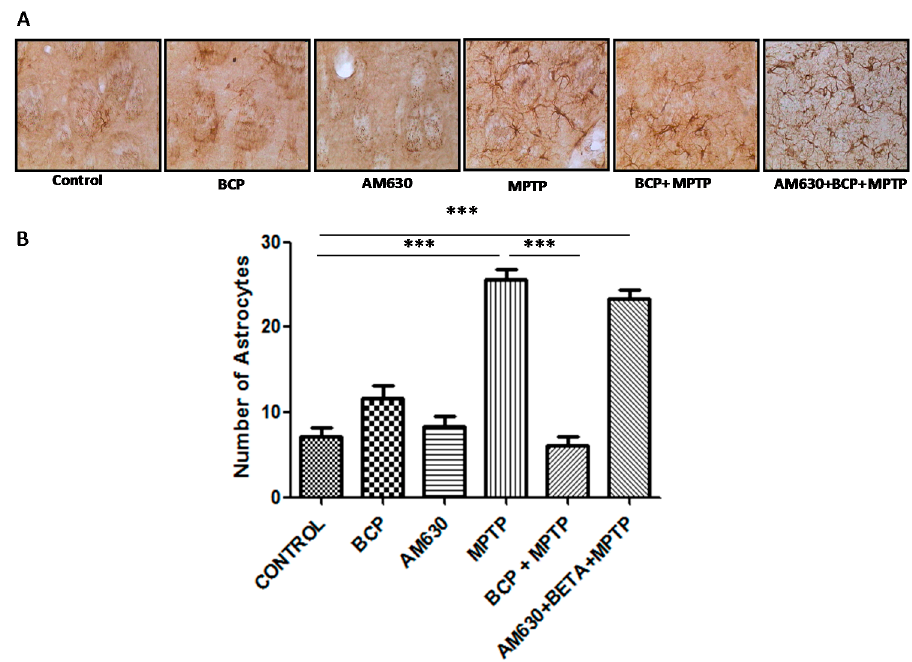
Figure 8. Effect of BCP on MPTP-induced astrocyte activation in the mouse STR. ( A ) Glial fibrillary acidic protein (GFAP)-IR astrocytes in mouse STR. Scale bar: 200 µ m. ( B ) Stereological cell counts of GFAP-IR astrocyte. The data are presented as mean ± SEM of six individual experiments. *** p < 0.001, CTL vs. MPTP. *** p < 0.001, MPTP vs. BCP+ MPTP. *** p < 0.001, CTL vs. AM630 + BCP + MPTP treatment.